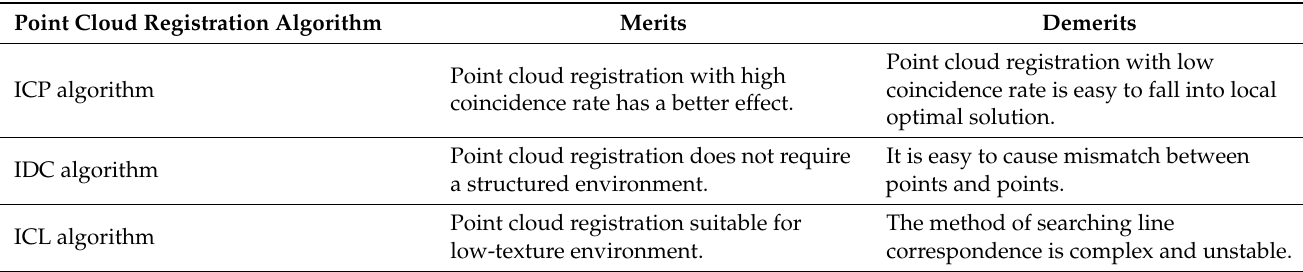
Table 1. The merits and demerits of point cloud registration